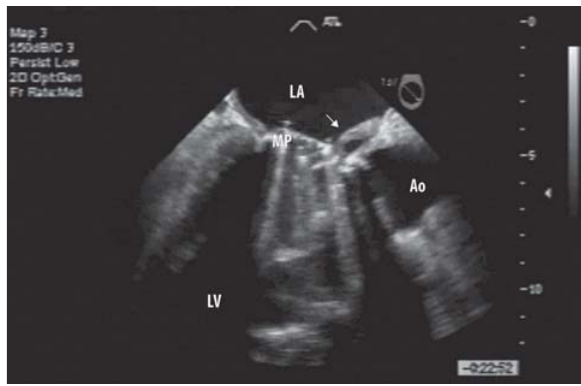
Fig. 1 - Transesophageal long-axis view showing a small abscess at the mitral-aortic intervalvular fibrosa. Abscess is the abnormal echolucent area within the intervalvular fibrosa